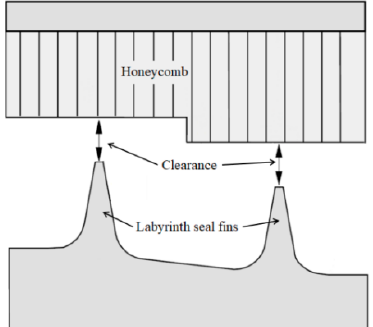
Figure 1. Labyrinth honeycomb sealing system.